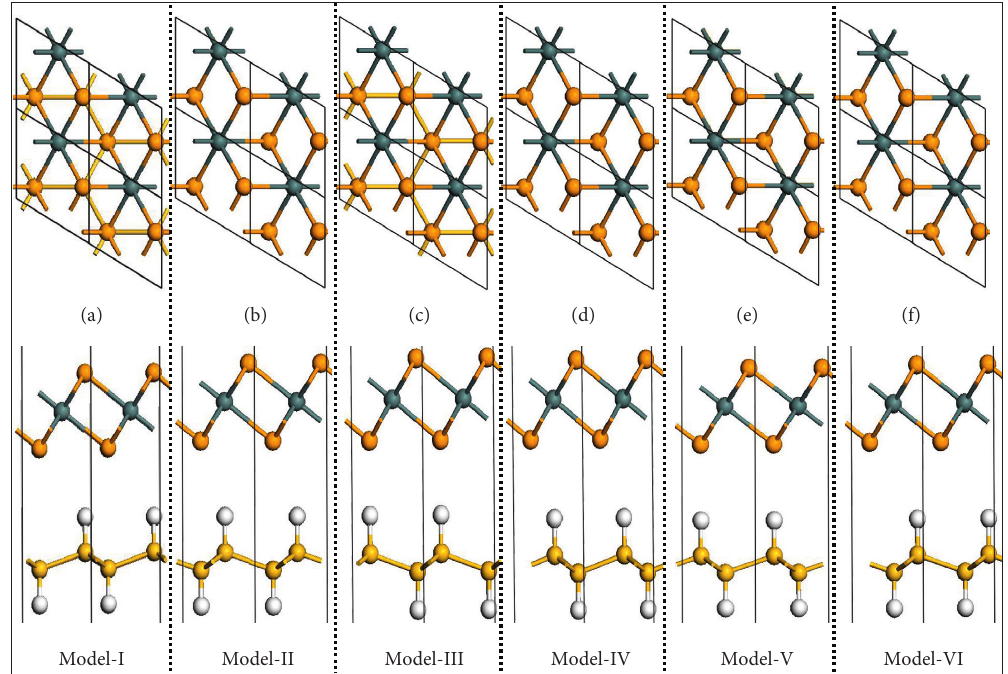
Figure 2: Depictions of the lattice structures (2 × 2) of the silicane/SnSe 2 vdW heterostructure, in which (a) Model-I, (b) Model-II, (c) Model- III, (d) Model-IV, (e) Model-V, and (f) Model-VI are illustrated. The upper diagrams show the top view, while the lower ones are the side view. The unit cells are represented by the black lines. Table 1: The formation energy ( E f ) of the heterostructure and the interface distance between the two layers ( Δ ) of the six stacking conformations. Model